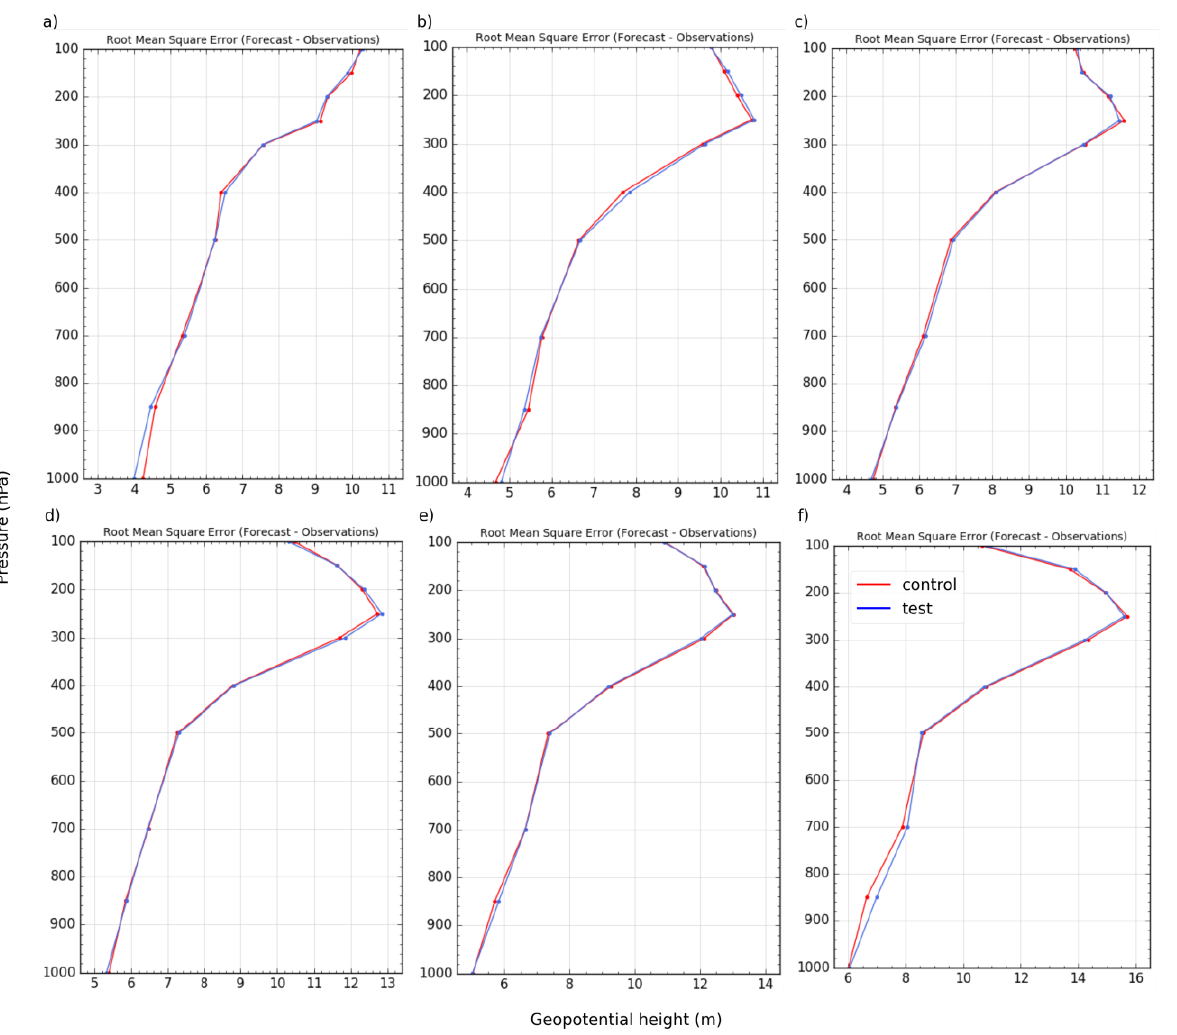
Figure 4. Vertical profile of the RMSE from the forecast at 6 h ( a ), 12 h ( b ), 18 h ( c ), 24 h ( d ), 30 h ( e ), and 36 h ( f ) for a geopotential height.